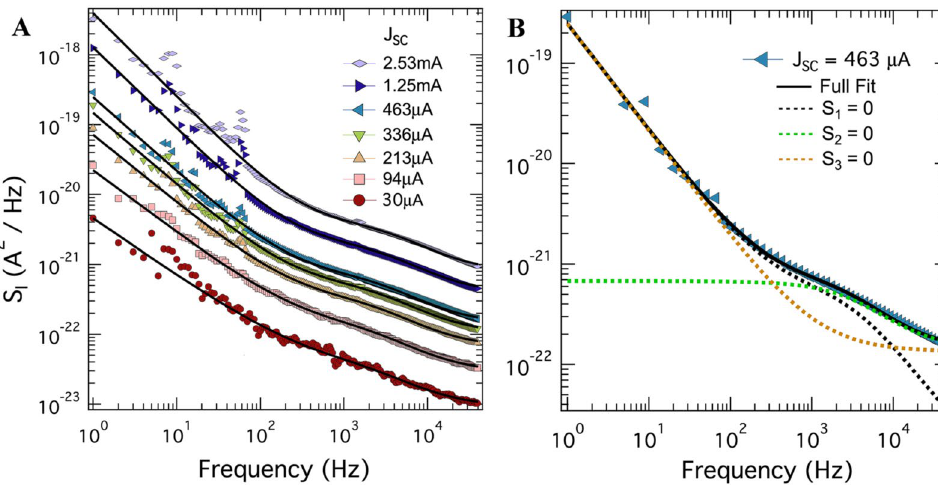
Figure 3. Current spectral density of the SHJ solar cell SC1 in short-circuit configuration under yellow light. ( A ) Frequency dependence of current noise power spectral density at 300 K under illumination with varying intensity from a narrow-spectrum yellow LED ( (cid:31) = 590 nm ). The legend indicates short-circuit DC current in the device. Black solid lines are fits to Eq. (3). ( B ) A representative noise spectrum corresponding to J SC = 463 μA, where each term in Eq. (3) is sequentially set to zero to illustrate the presence of both frequency- independent and generation-recombination